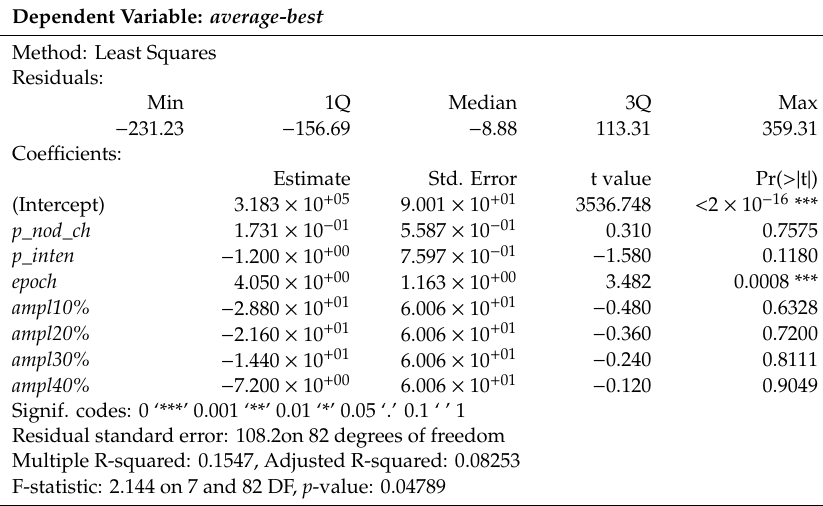
Table 8. Regression model for average-best , instance